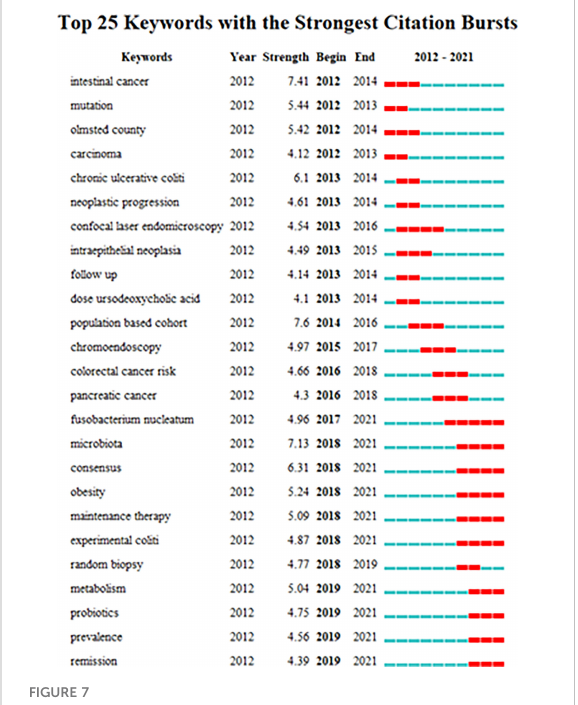
FIGURE 7 The top 25 keywords with the strongest citation